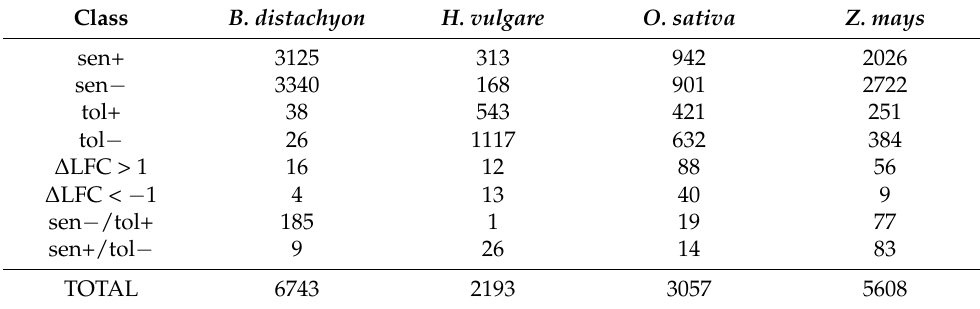
Table 3. Genes putatively involved in the tolerant response to drought stress. The numbers of genes belonging to the eight classes were reported for each dataset.